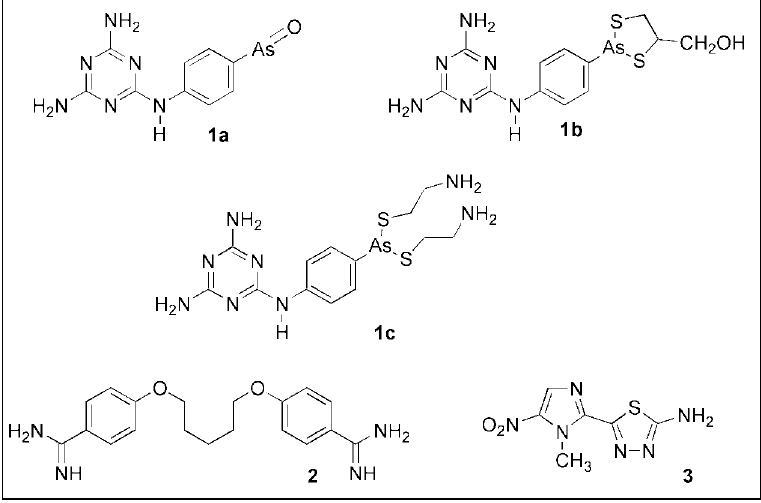
Figure 1 - Structures of melarsen oxide (1a), melarsoprol (1b), cymelarsen (1c), pentamidine (2) and megazol (3).